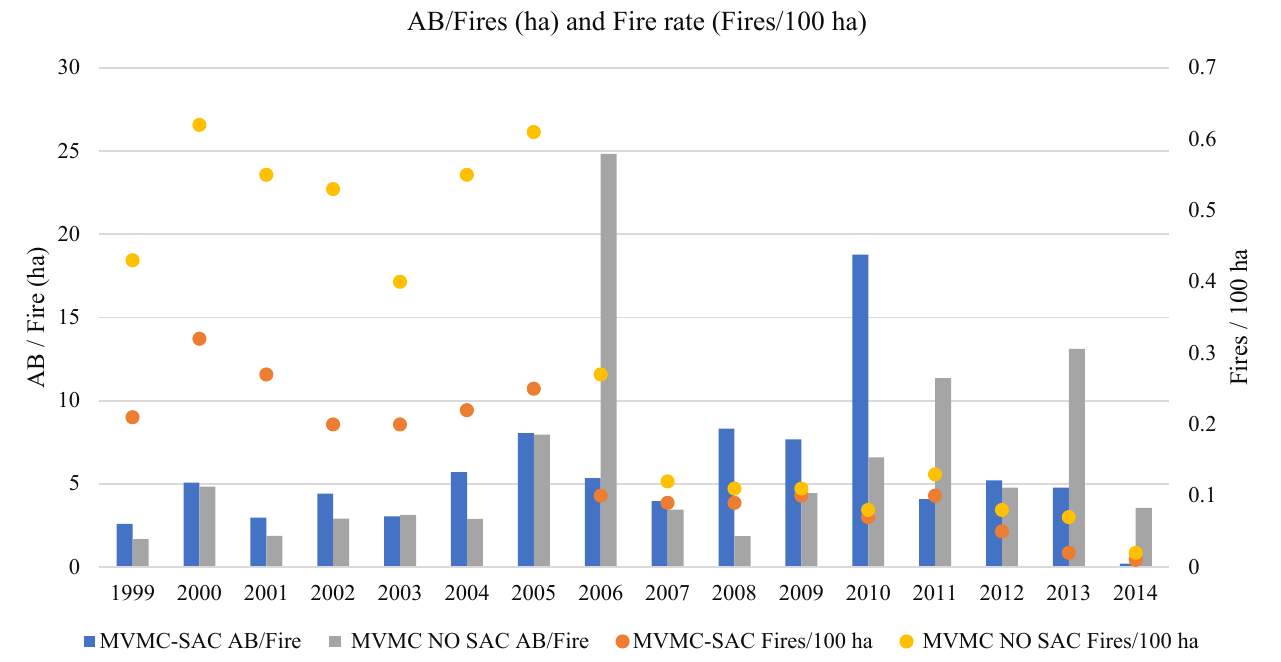
Figure 15. The area burnt per fire (AB/fire) and the rate of fires per 100 ha (orange and yellow dots) in MVMC-SAC and MVMC no SAC during the study period. The rate of fires per 100 hectares in both territorial units was similar after 2005. Table 6. Significant differences in the rate of forest fires and in the area burned by fire (BA/wild- fire) in MVMC-SAC and MVMC no SAC after 2004.